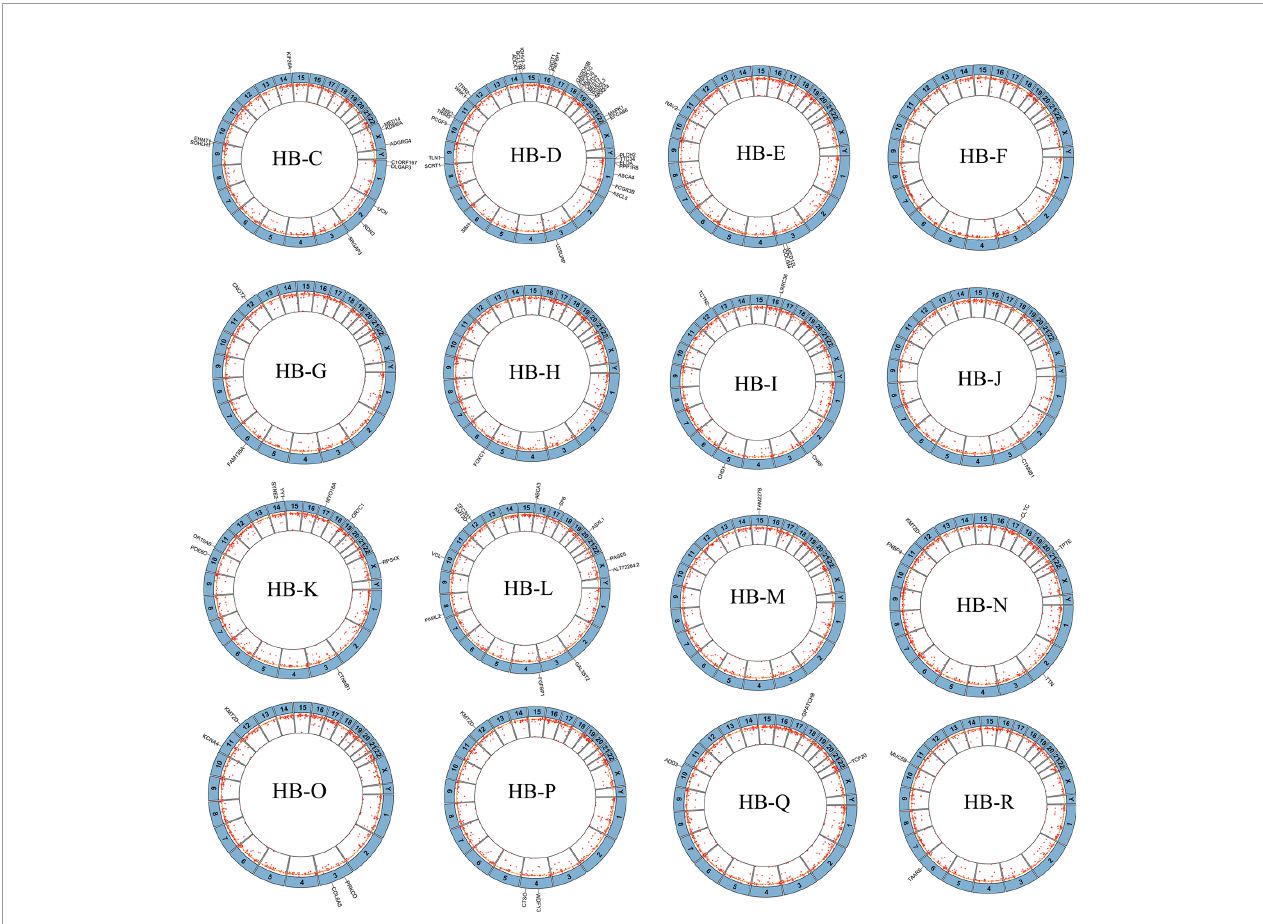
FIGURE 2 | Mutations and copy number alterations (CNAs) in hepatoblastoma tumors in our center. Circos plots of sequence alterations and DNA CNAs in each of the 16 hepatoblastoma samples, with mutated genes depicted outside of each circle. The inside ring shows copy number gains (outside yellow circle) and losses (inside yellow circle). Non-chemotherapy group HB patients: HB-K, HB-L, HB-M, HB-N, HB-P, HB-Q, HB-R. Chemotherapy group HB patients: HB-C, HB-D, HB-E, HB-F, HB-G, HB-H, HB-I, HB-J,